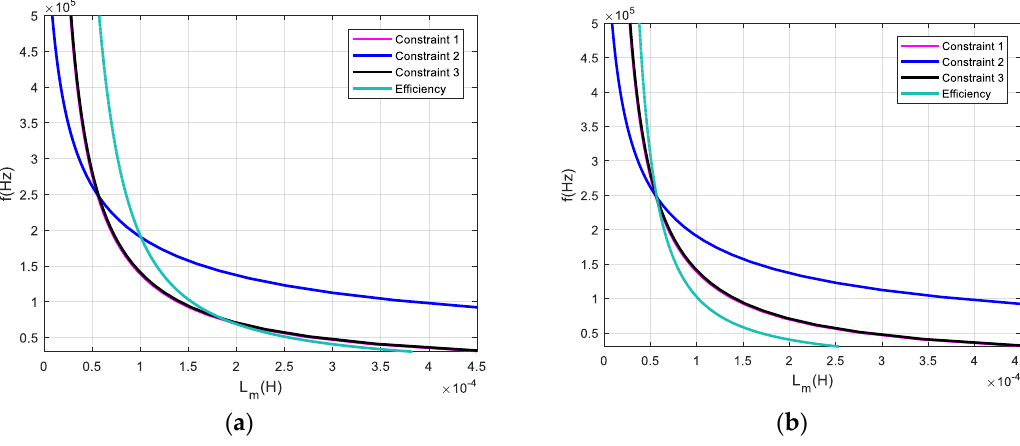
Figure 9. Influence of expected efficiency on the restricted design area of the converter: ( a ) Increased efficiency; ( b ) Decreased efficiency.